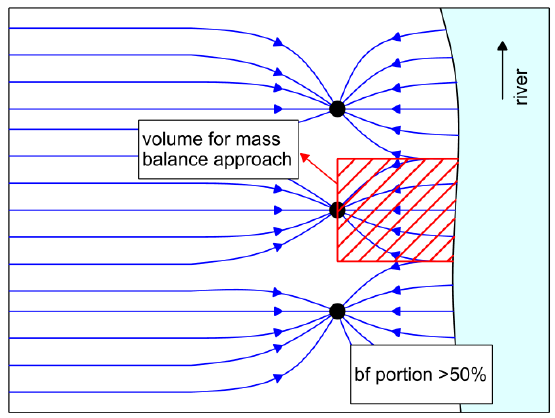
Figure 12. Approach to determine the aquifer volume from which iron could be